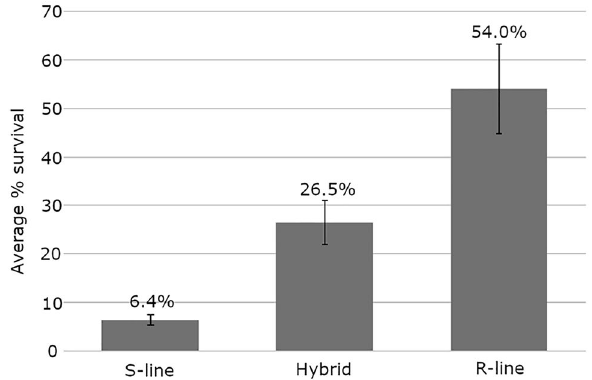
Figure 6. Comparison of average survival in the WSSV susceptible, resistant and hybrid starting